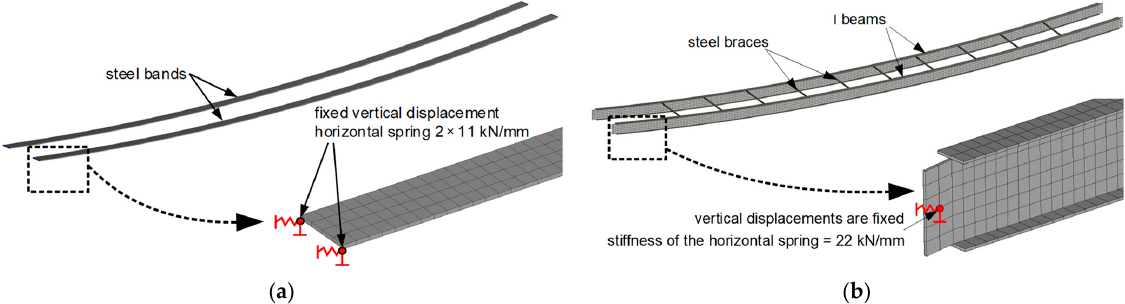
Figure 8. The bridge prototypes’ FE models: ( a ) model with flexible bands ( Model-1 ); ( b ) model with flexural-stiff ribbon- profiles ( Model-2 ).